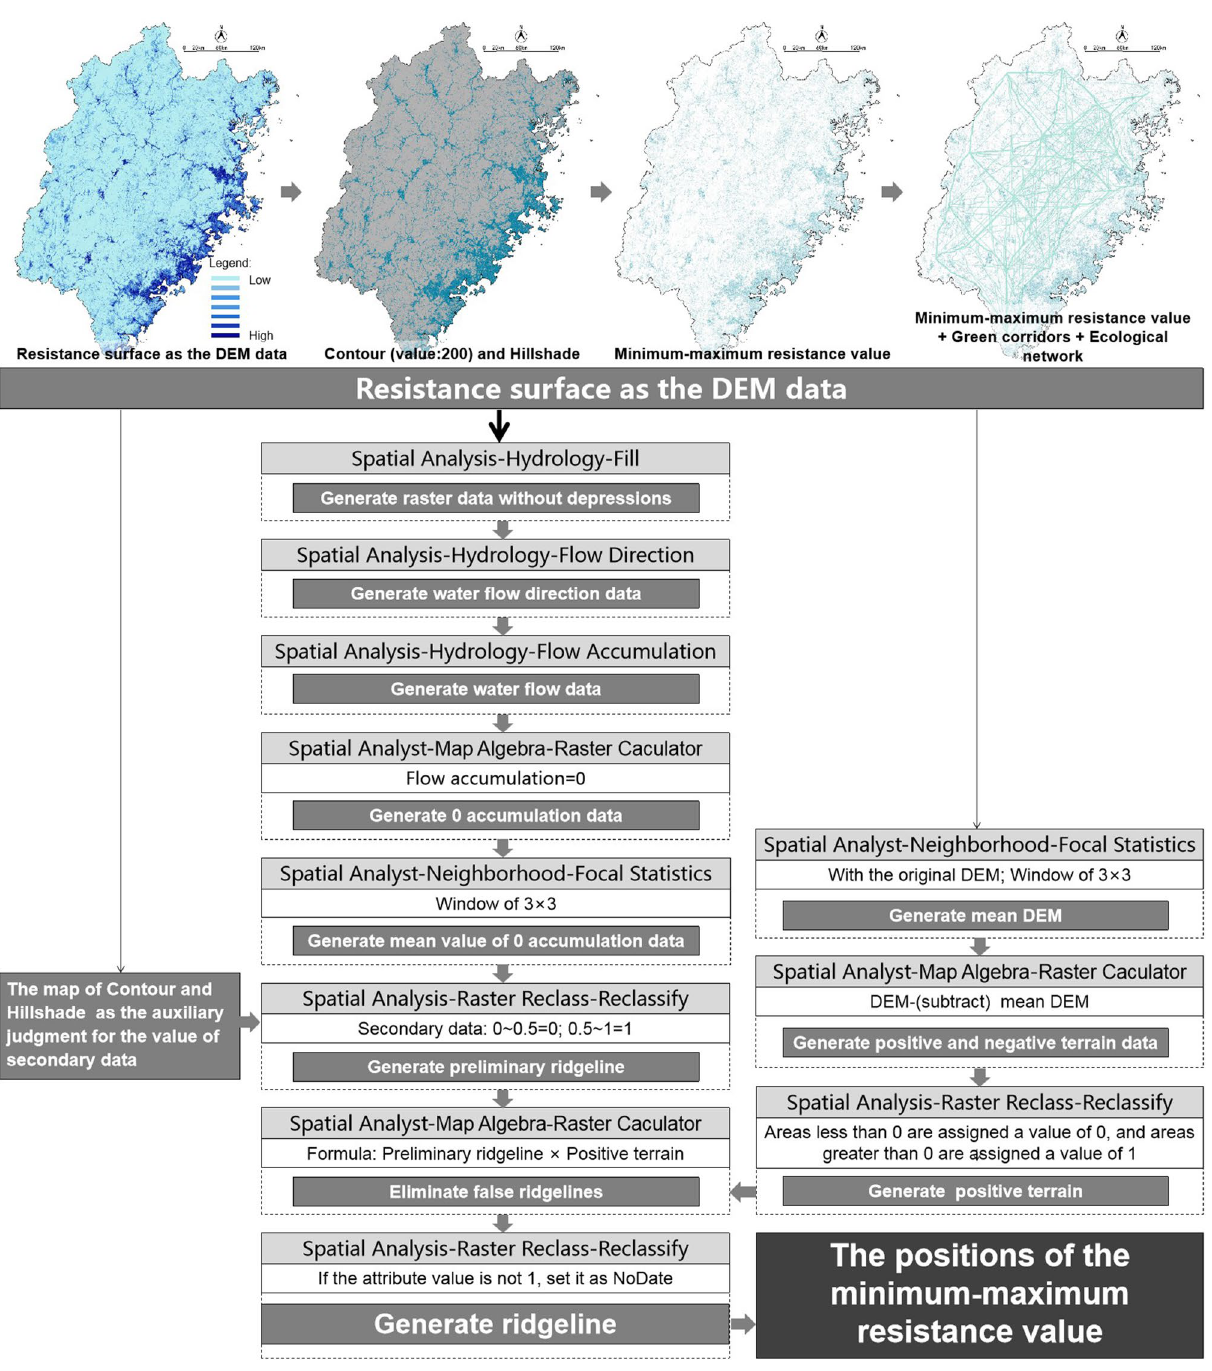
Figure 12. Diagram presenting the identification of ecological nodes in Fujian